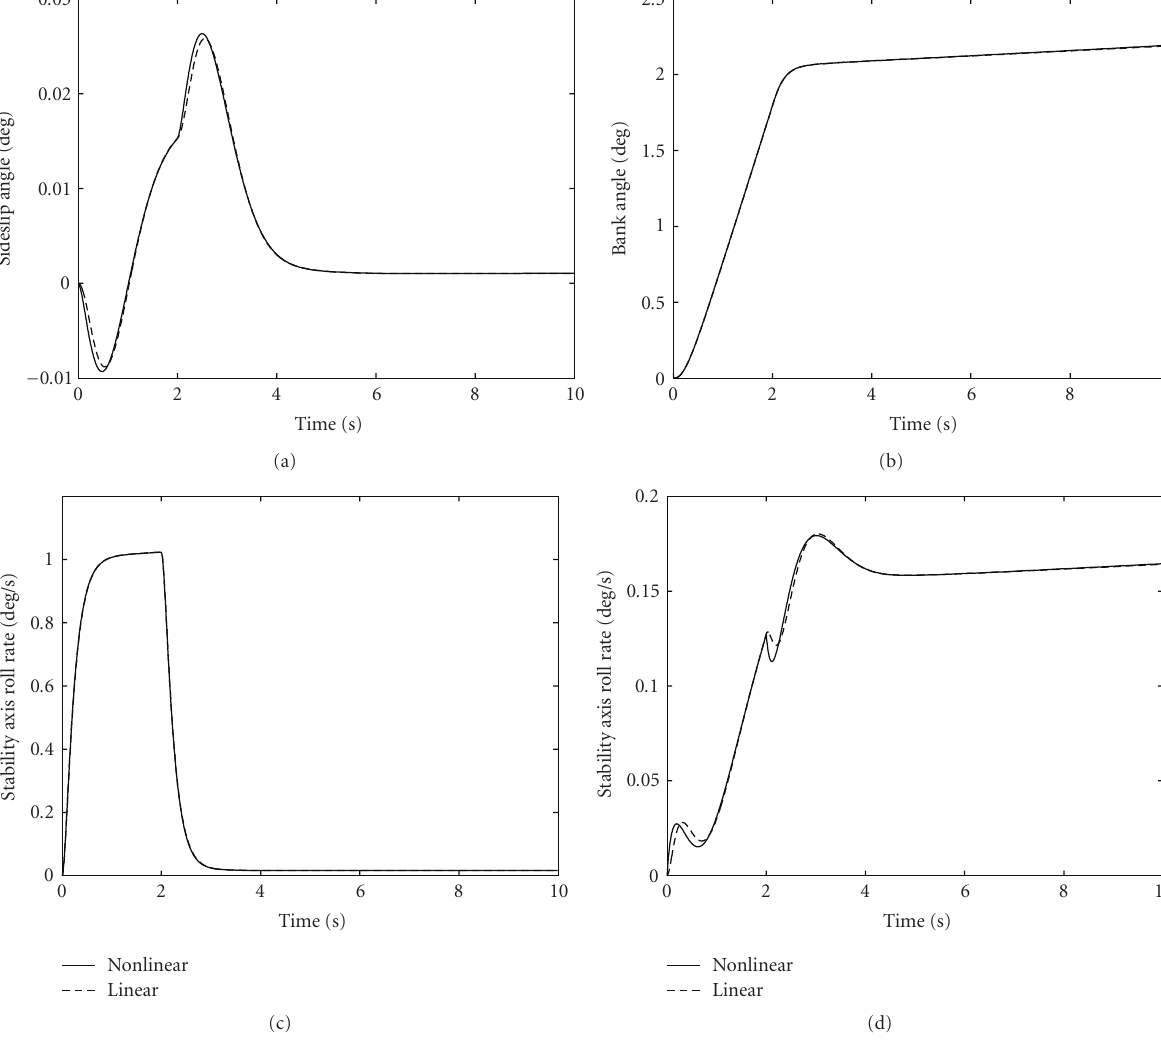
Figure 8: Nonlinear time responses to a 1 deg/s p s